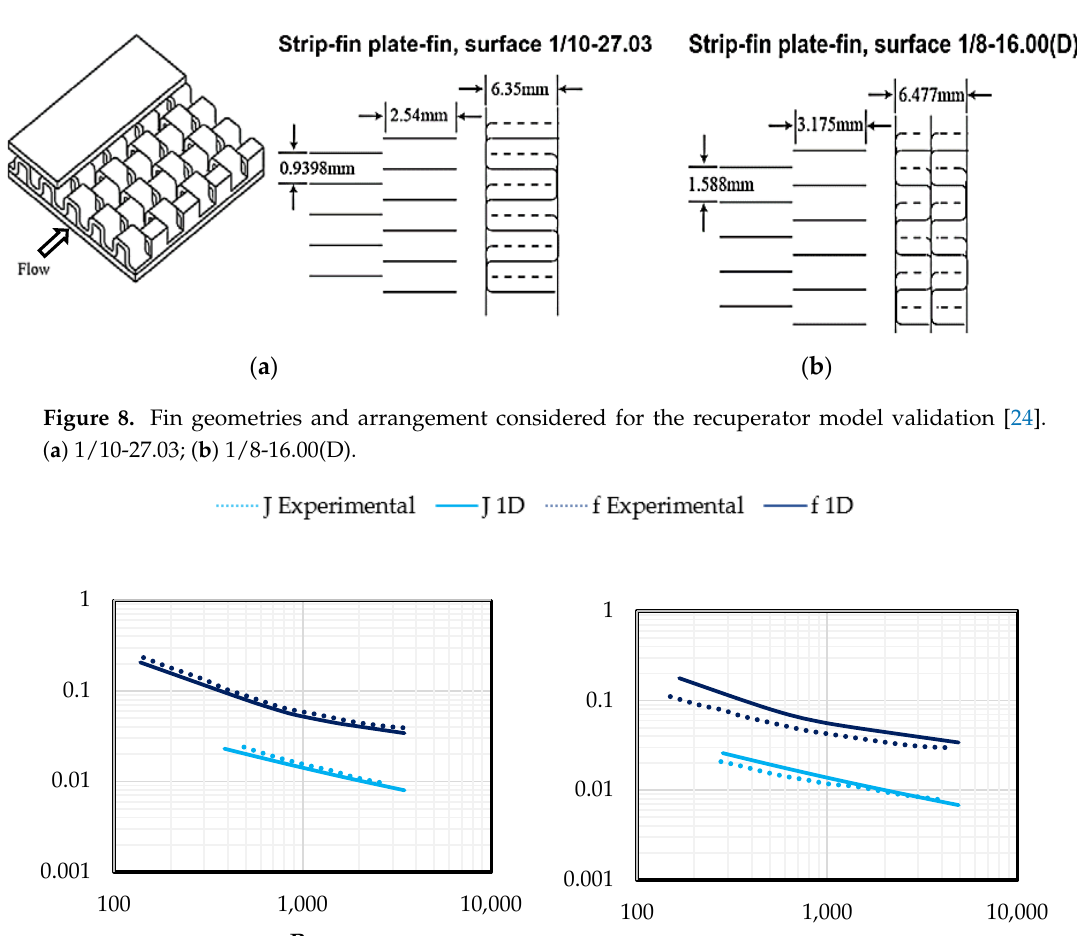
12 of 27 Figure 6. Compressor validation: characteristic maps for Eckardt impeller A. ( a ) Total to static isentropic efficiency vs mass flow rate; ( b ) pressure ratio vs mass flow rate. For the case of KIMM compressor geometry, the efficiency chart was not available and the comparison has been performed only on the pressure ratio. Results show better agreement with the experimental results when compared to the other two compressor geometries showing a maximum relative error of 1.5%. This demonstrates the suitability of the present model for smaller size compressors. Figure 7. Compressor validation: characteristic maps for KIMM impeller. 2.3.2. Recuperator Off-Design Model Validation The model for the recuperator has been validated against available experimental data for a range of fin geometries as proposed by [24]. The fin geometries and arrangements used for the validation, namely, 1/10-27.03 and 1/8-16.00(D) fin geometries, are presented in Figure 8 and more details of the geometry are given in [24]. Figure 9 shows the modelling results of the Colburn factor ( J ) and friction factor ( f ) for both 1/10- 27.03 and 1/8-16.00(D) fin geometries. The modelling for the first geometry presents a maximum relative error of 3% for both Colburn factor and friction factor. Nevertheless, there is some inaccuracy